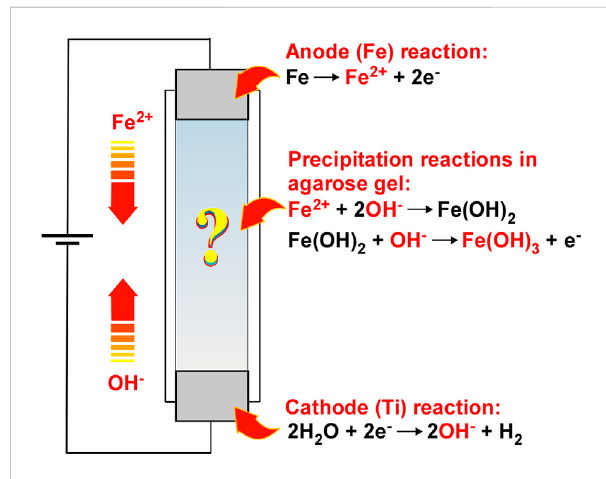
FIGURE 1 Schematic illustration of the reaction – diffusion – reaction (RDR) system, wherein (1) electrochemical reactions to generate reactant ions, (2) diffusion of the reactant ions in fl uenced by an electric fi eld, and (3) reactions of the reactant ions to form precipitates are coupled to generate precipitation patterns of Fe(OH) 3 in agarose hydrogel. The arrows indicate the directions of movement of the reactant ions in the electric fi